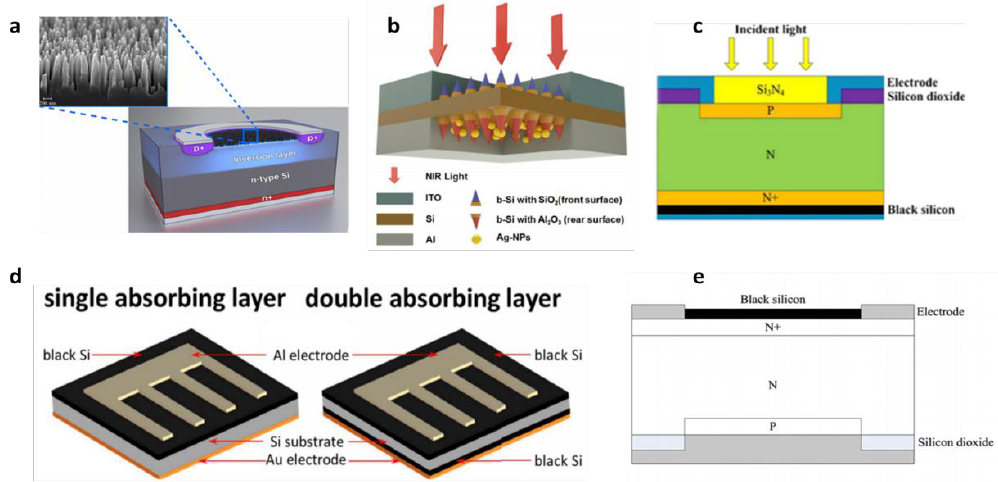
Figure 10. Photodetector based on black silicon with different principles and structures. ( a ) Cross-section of induced- junction b-Si photodiode structure with high EQE in the 250 nm to 950 nm. ( b ) Schematic of b-Si/Ag-NPs Schottky photodetector. Adapted from reference [52]. ( c ) Structure of Si-PIN photoelectronic detector with microstructure black silicon at the back surface. Adapted from reference [50], with permission from Springer Nature © 2020. ( d ) Two different schematic diagrams of nitrogen-doped black silicon photodiodes with single layer or double layers black silicon. Adapted from reference [93], with permission from IEEE © 2020. ( e ) Structure of Si-PIN detector based on nanostructured black silicon. Adapted from reference [94].